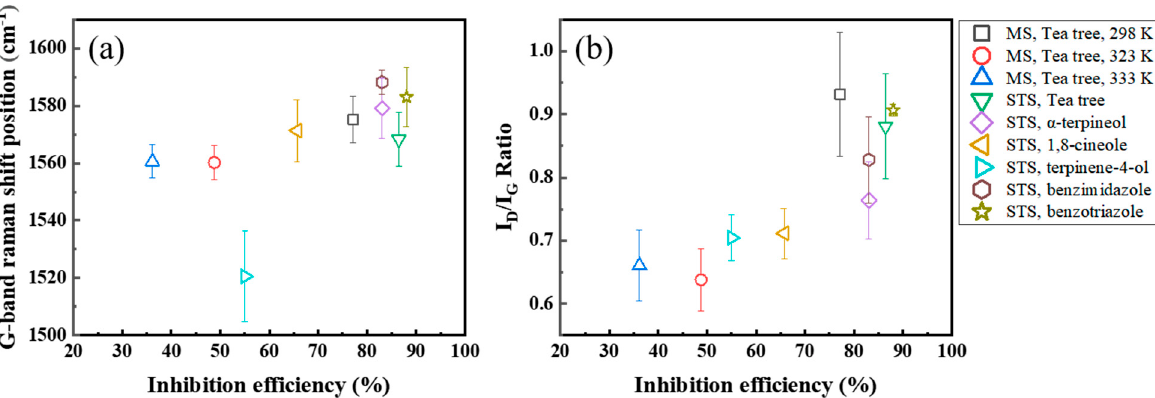
Figure 13. Behavior of ( a ) the G-peak position and ( b ) the I D /I G intensity ratio with the IE WL of organic inhibitors. Table 4. The intensity ratio of the D-peak to G-peak (I D /I G ) and the G-peak position (cm − 1 ) evaluated in Figures 9–12. Inhibitor